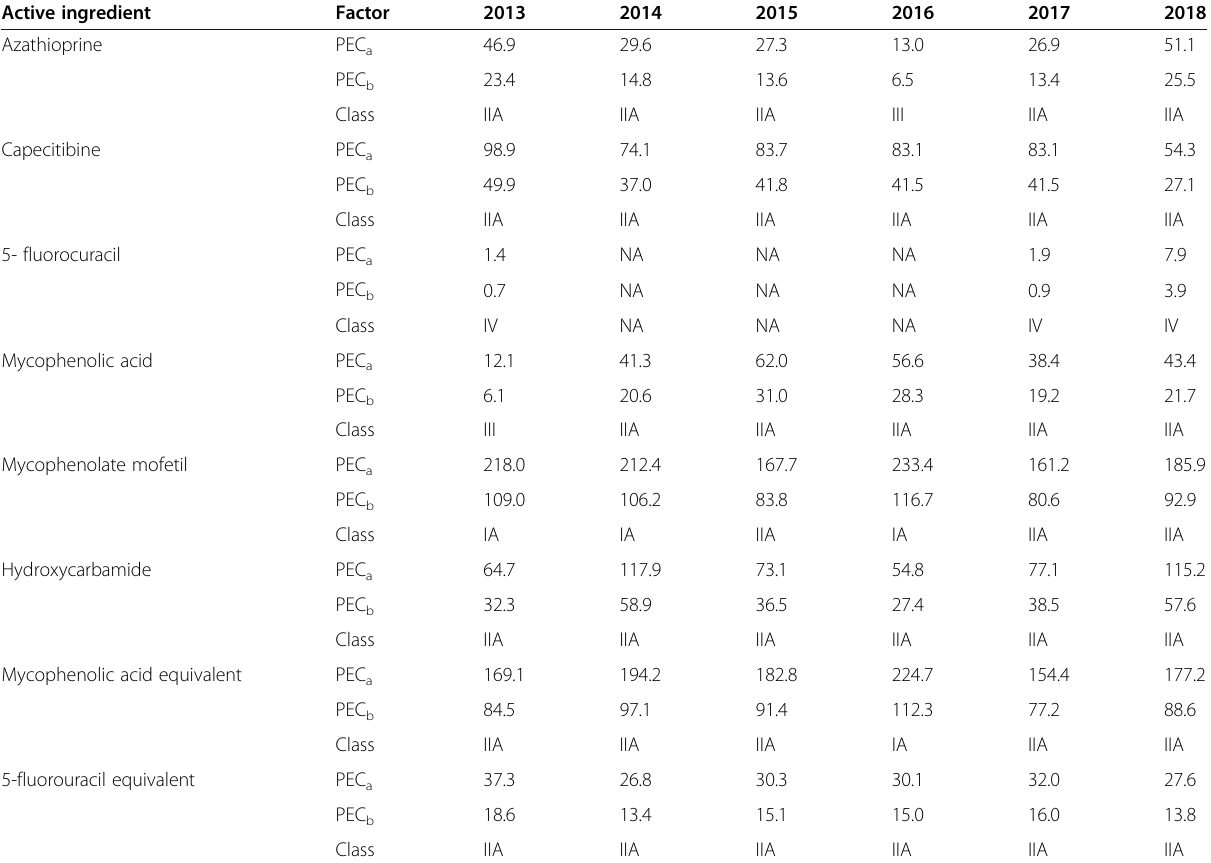
Table 4 PEC a (ng L − 1 ), PEC b (ng L − 1 ), and risk categorization of the priority anticancer drug and their corresponding equivalents between the years 2013 and 2018 Active ingredient